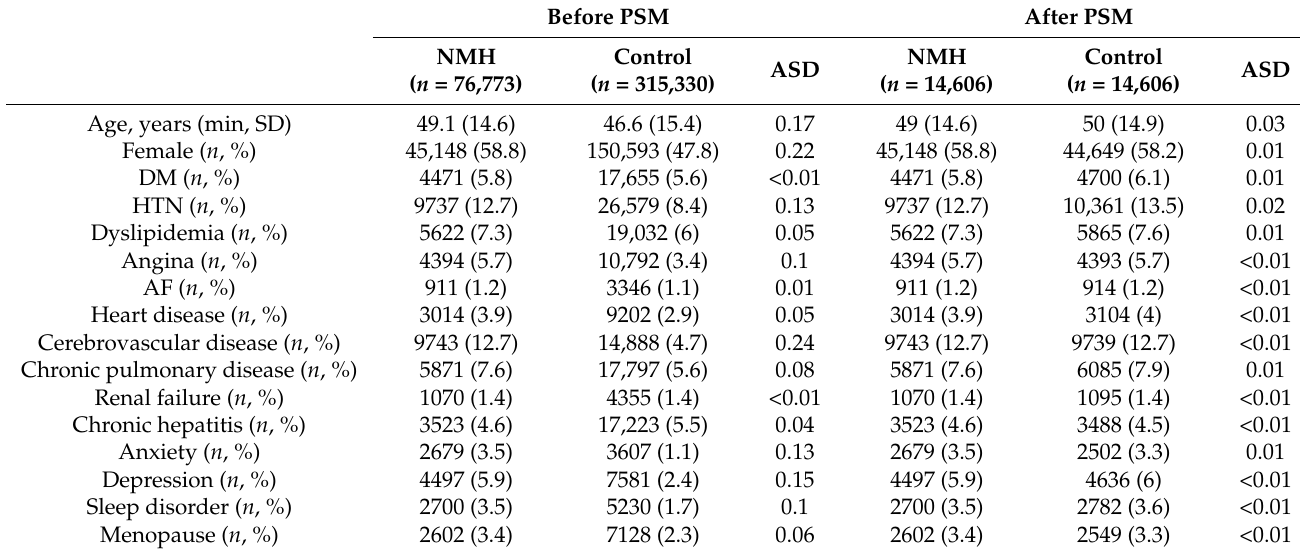
Table 2. Characteristics of the non-migraine headache and control groups before and after PSM.